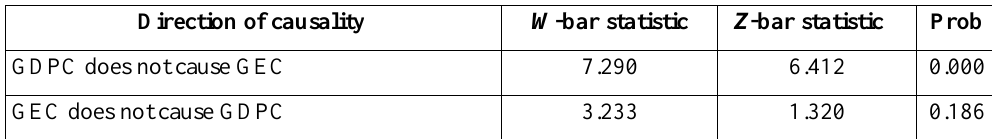
Table 5. Dumitrescu Hurlin Causality Test Results